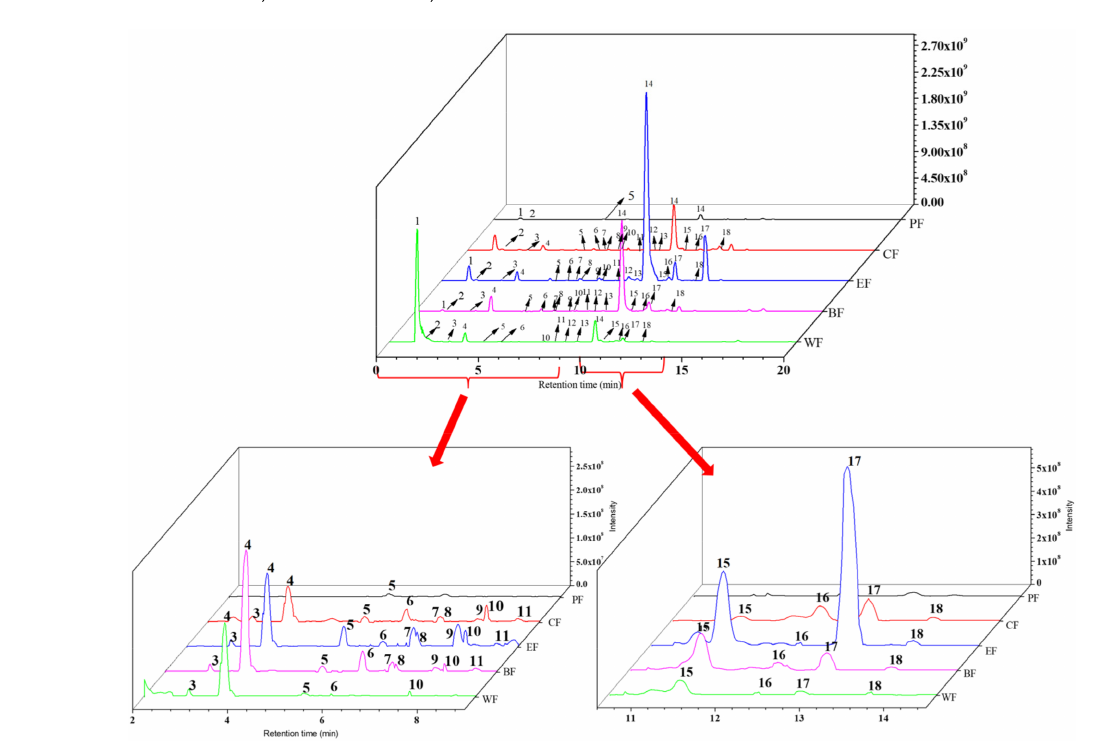
Figure 2. Negative ion chromatograms of phenolic compounds from PF, CF, EF, BF, and WF from Vaccinium dunalianum. PF, CF, EF, BF, and WF denoted petroleum ether fraction, chloroform fraction, ethyl acetate fraction, n -butanol fraction, and water